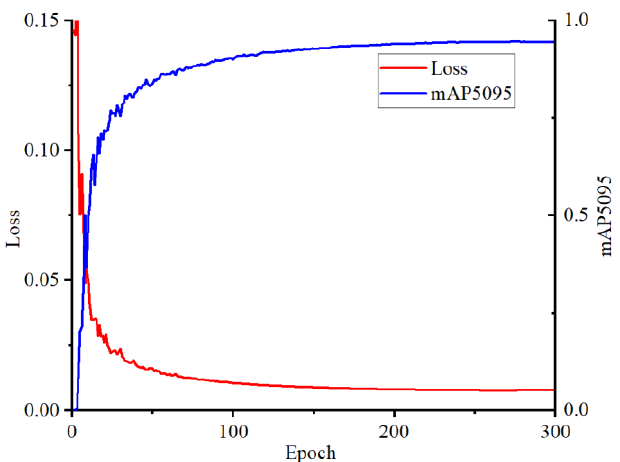
Figure 14. Loss and mAP during training of YOLOv5 model in the test field